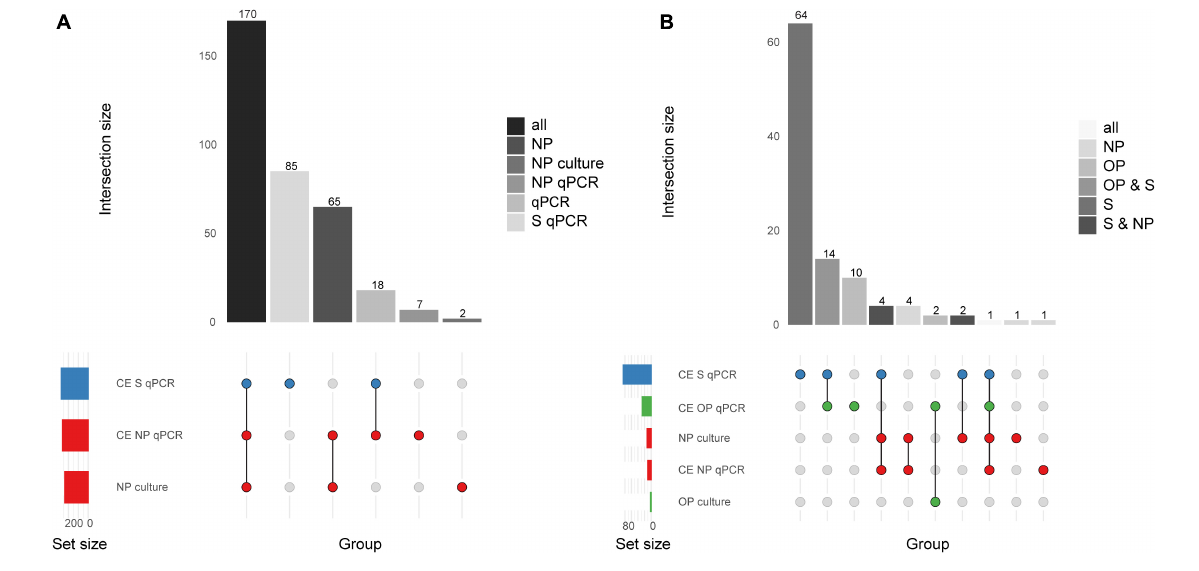
FIGURE4 Quantitative PCR-based serotyping Streptococcus pneumoniae positive saliva (S) and nasopharyngeal (NP) samples from (A) young children ( n = 653) and (B) qPCR-based serotyping of S. pneumoniae positive saliva, nasopharyngeal, oropharyngeal (OP) samples from adults ( n = 318). The intersection bar diagrams display the total number of individuals positive per intersection. The matrix diagram displays intersection components (method or criterion). The set size bar diagram displays the total number of individuals positive per intersection component. Saliva, oropharyngeal, and nasopharyngeal samples are colored blue, green, and red, respectively, in the matrix